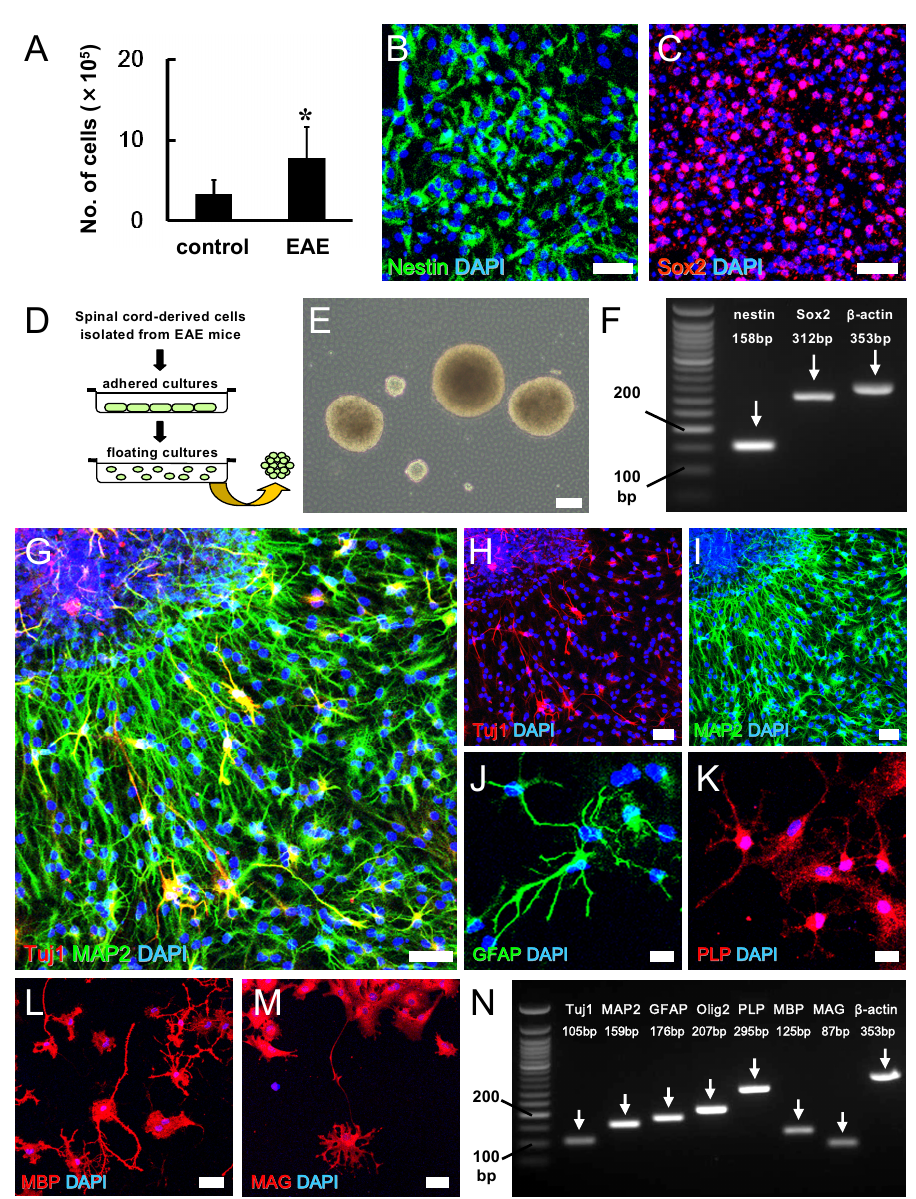
Figure 7. The numbers of adherent cells isolated from spinal cords were significantly higher in EAE mice ( N = 9) compared with control mice ( N = 5) ( A ). Immunohistochemistry showed that cells isolated from EAE mice expressed Nestin (Nestin [ B : green] and DAPI [ B : blue]) and Sox2 (Sox2 [ C : red]